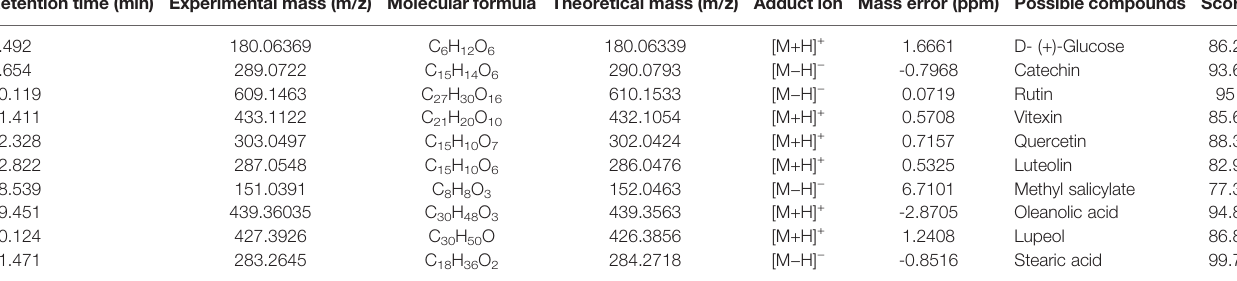
TABLE 1 | Relevant analytical data for compounds isolated from CNC